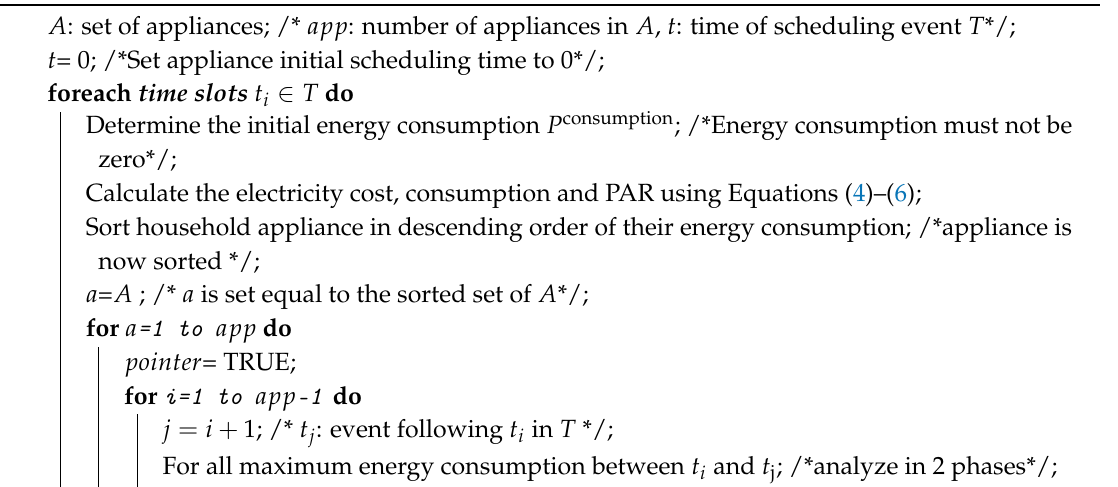
Algorithm 1: Proposed optimal scheduling technique